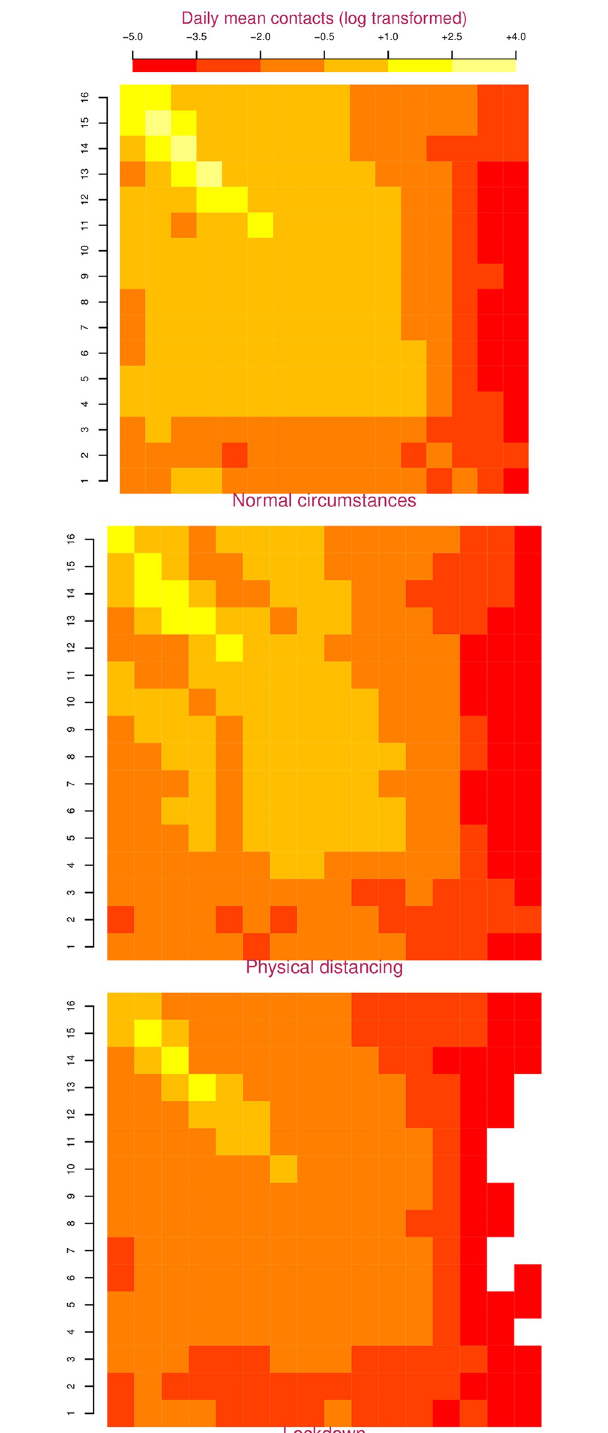
Fig 1. Age and intervention specific contact matrices for Nepal. In these matrices, the population is divided into 16 5-year age-groups represented along the two axes that start at the top left. The top left square represents contacts between 0–4 year olds and the bottom right square represents contacts between individuals who are 75 years and older. Colors in the squares represent the log transformed mean daily contact rate between corresponding 5-year age-groups cohorts. Dark/red colors represent fewer contacts, light/yellow colors represent a greater number of contacts. Physical distancing causes the lighter squares to darken indicating fewer contacts, while a lockdown causes the lighter squares to darken even